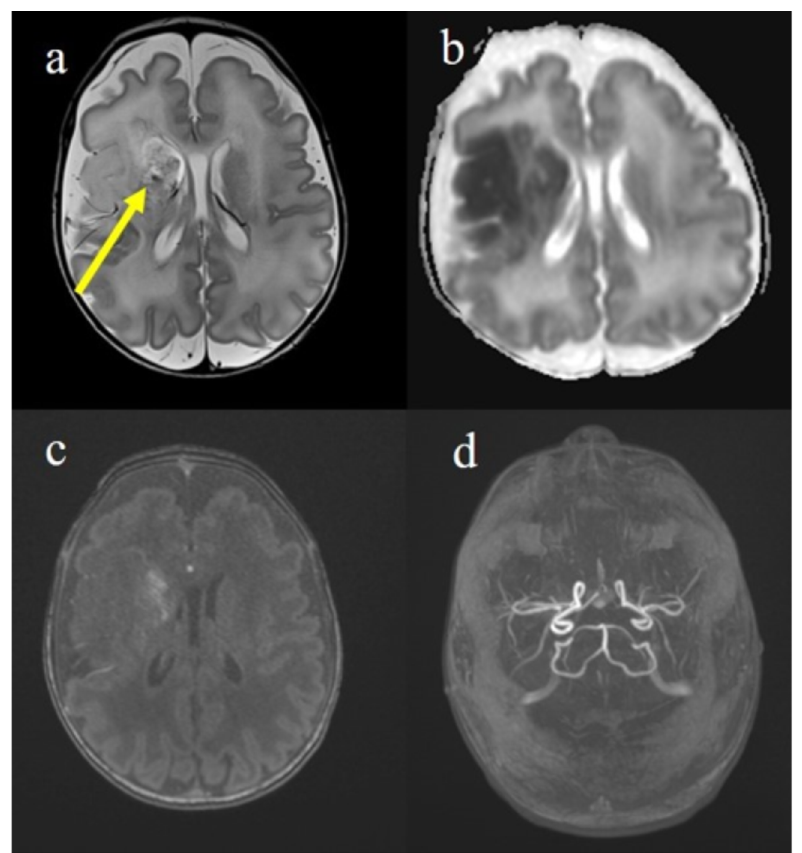
Figure 1. Brain MRI on 3 T performed on the 5th day of life showed hyperintense areas on the T2 sequence ( a ) in the right fronto-temporal regions involving the head, the caudate nucleus that appeared also with hypointense foci for hemorrhagic infiltration (yellow arrow). At the same level, areas with low ADC ( b ) corresponding to restricted diffusion were represented. On the Angio-TOF sequences, the petechial hemorrhagic infiltration was visible ( c ) in absence of arterial occlusion ( d ). These findings were compatible with ischemic stroke of the right middle cerebral artery (MCA) in a subacute